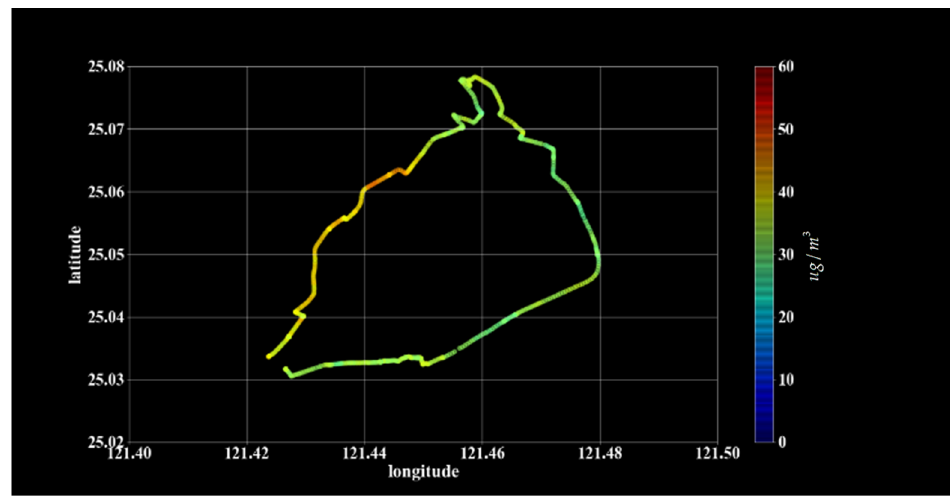
Figure 7. Mobile sensing data at 11:00 A.M. on 20 January 2019.